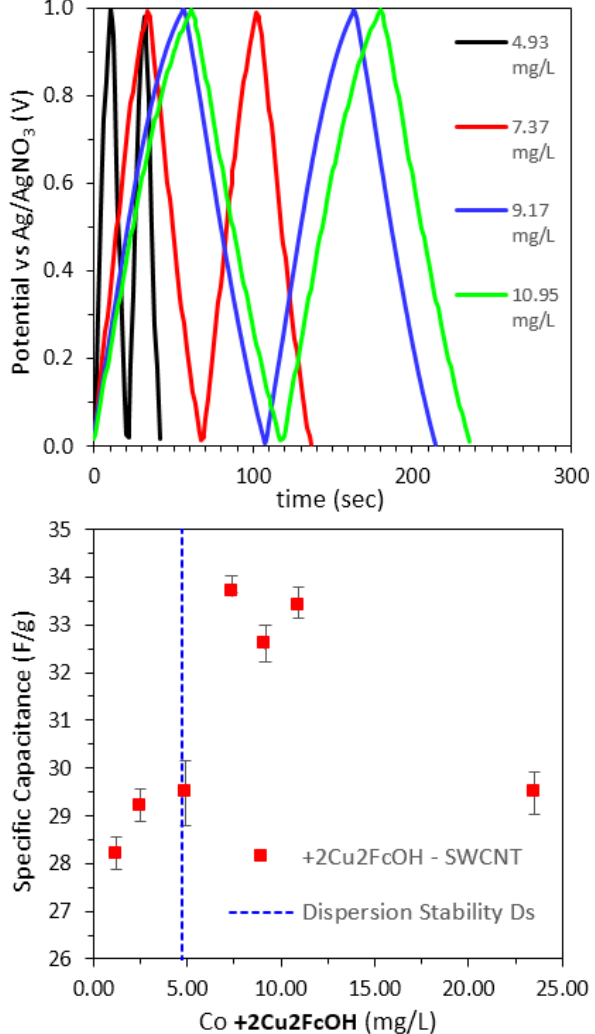
Figure 16. GCD curves ( top ) and specific capacitance data of thin film HiPco films after functionalization with the + 2Cu2FcOH spacer at various initial concentrations. All films in the GCD graph were made with above the dispersion stability concentration of the spacer. As the initial concentration of the spacer increases well beyond the dispersion stability concentration, the CNTs rapidly aggregate before the film can be formed, resulting in the low capacitance shown at 23 mg/L.